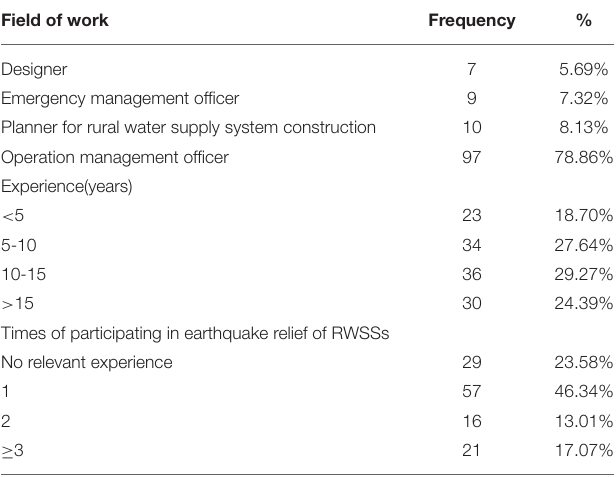
TABLE 3 | Summary of the profiles of